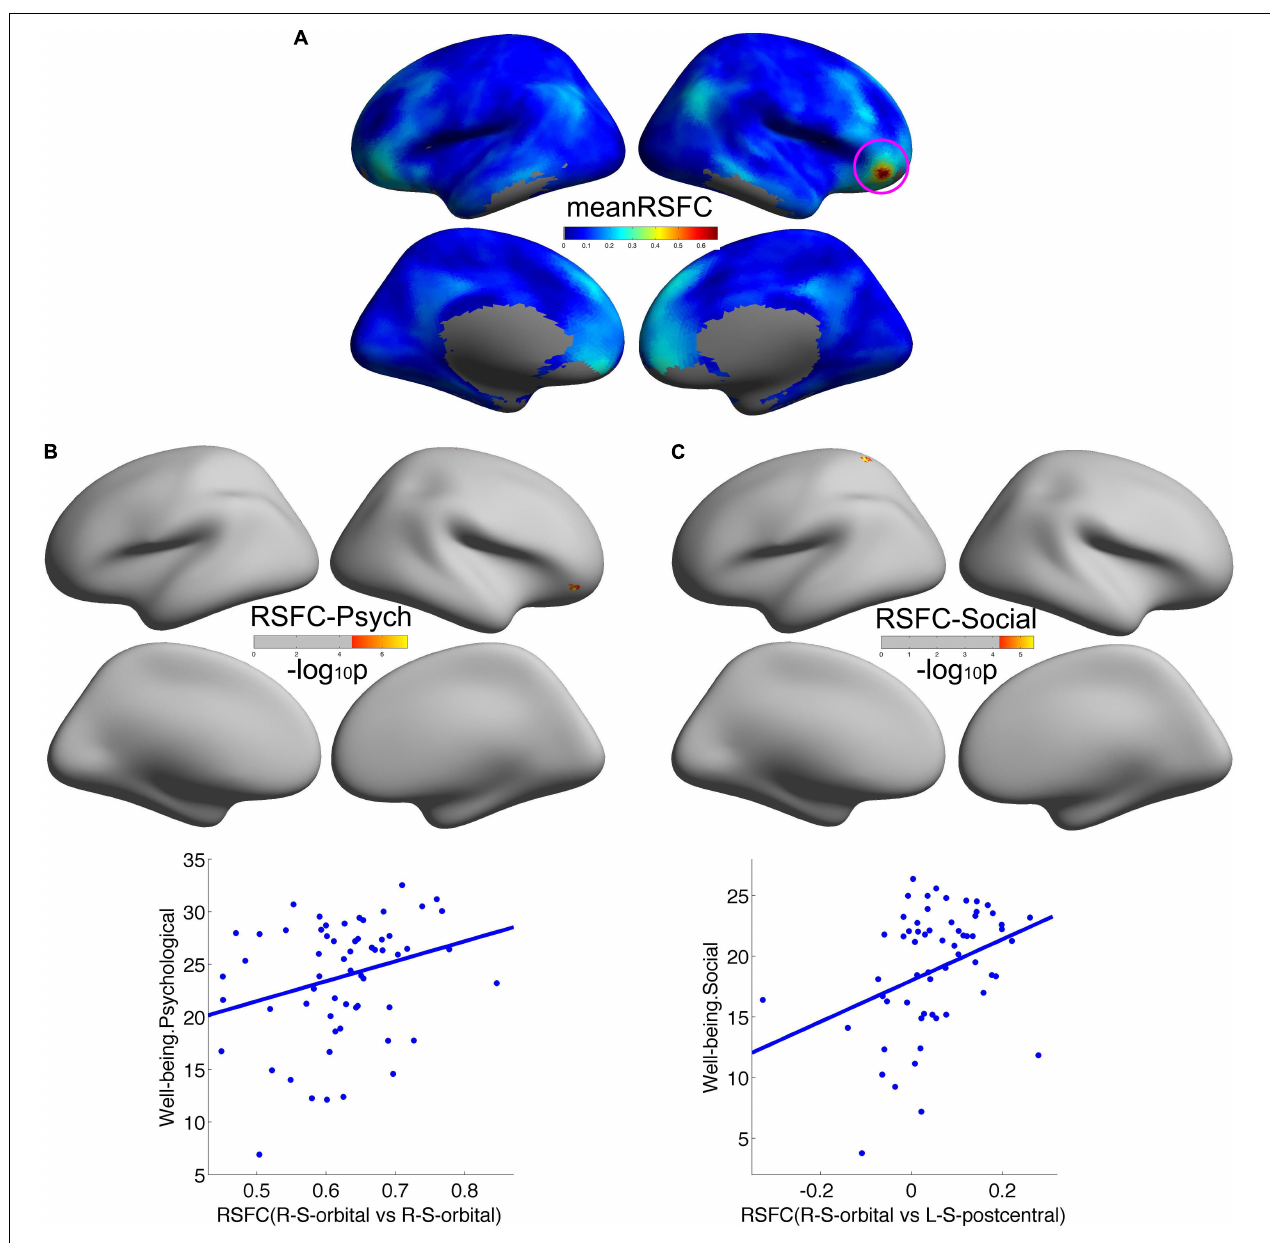
FIGURE 2 | Remote cortical connectivity in healthy participants and its associations with wellbeing. (A) Illustrated the average resting-state functional connectivity (RSFC) across all the participants taking the psychological wellbeing-related right orbitofrontal sulcus as the seed region. Remote cortical connectivity within the right orbitofrontal cortex was positively correlated with psychological wellbeing (B) , as well as remote cortical connectivity between the right orbitofrontal sulcus and the left postcentral sulcus was positively correlated with social wellbeing (C)